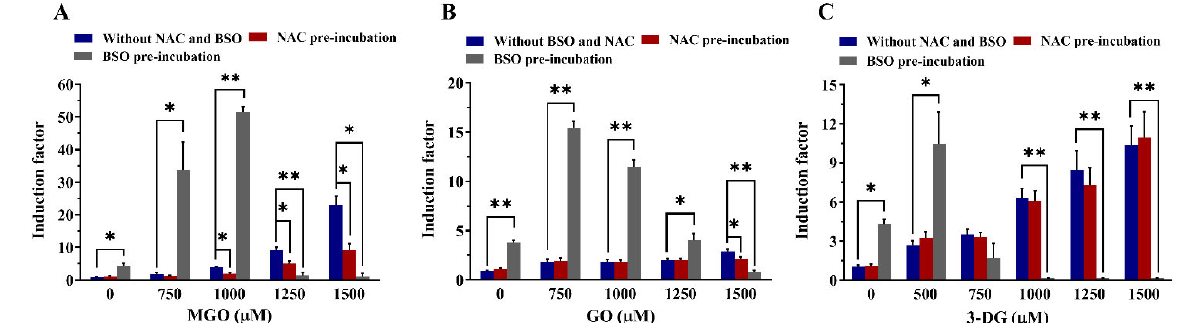
Figure 10. Effects of altered intracellular GSH levels on the induction of Nrf2-mediated gene expression upon 24 h exposure to MGO ( A ), GO ( B ), and 3-DG ( C ). Note the different size of the Y-axes. Data are shown as mean ± SEM of at least three independent replicates. * p < 0.05 and ** p < 0.01.